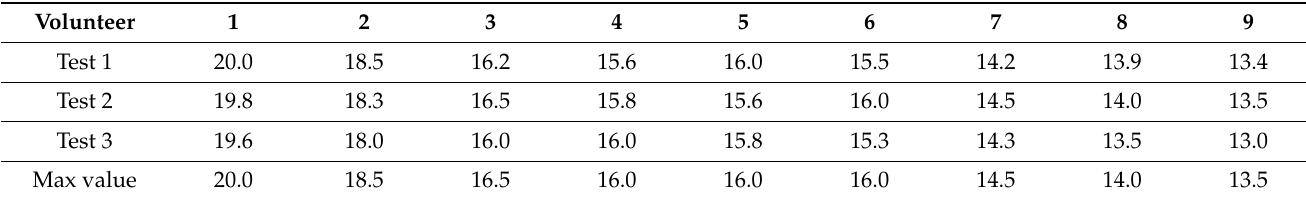
Table 1. Maximal voluntary contraction (MVC) force of each volunteer (/N).